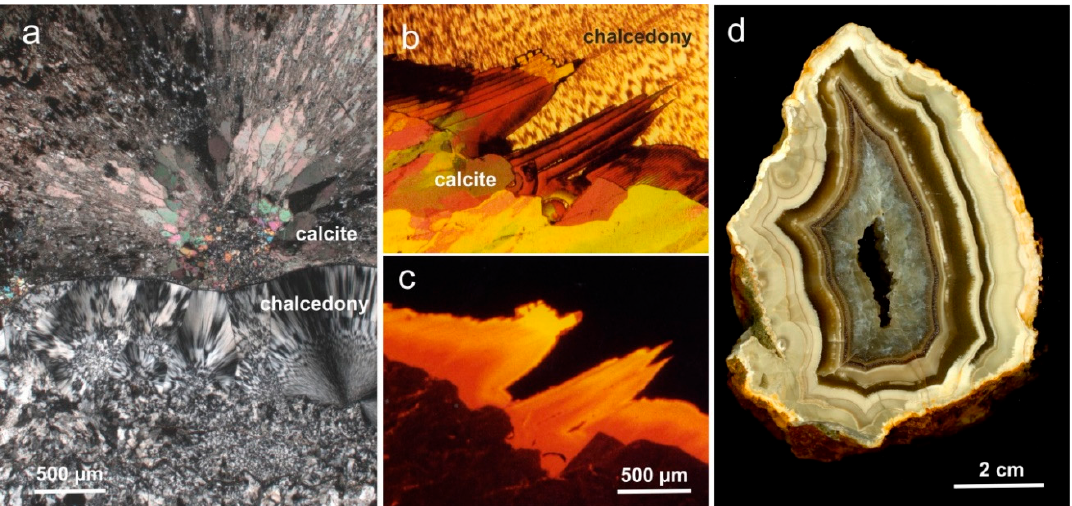
Figure 21. Appearance of calcite in agates: ( a ) micrograph in transmitted light (crossed polars) of the transition zone between chalcedony and calcite in an agate from Xuanhua, province Hebei (China); note the sharp boundary between the two phases and the spherulitic growth of calcite; ( b , c ) micrographs in transmitted light (crossed polars, ( b )) and CL ( c ) of an agate from Agate Point, Canada showing two calcite generations (dark brown, orange CL) in chalcedony matrix (dark); the second calcite generation replaces the banded chalcedony and forms pseudomorphs; ( d ) “calcite agate” from Krásný Dvore č ek (Czech Republic) with the typical banded appearance of agate but consisting completely of carbonate.